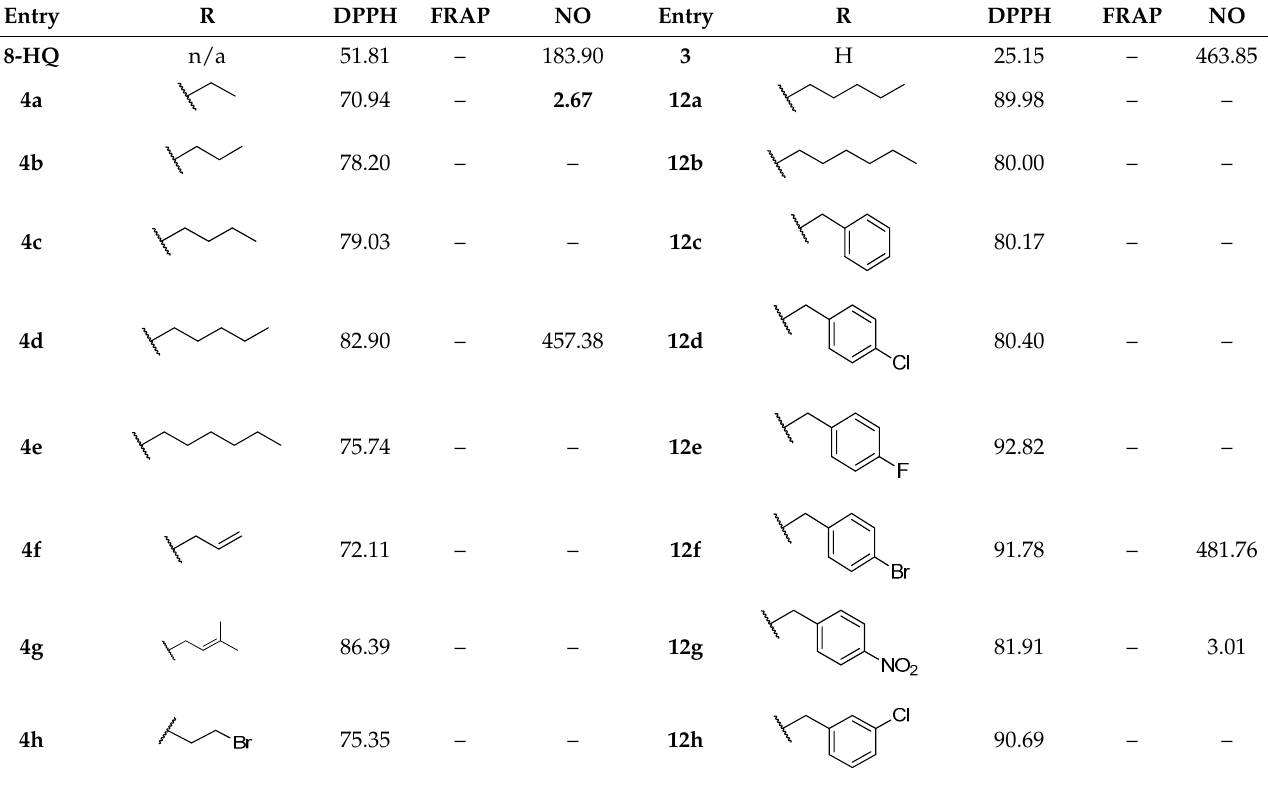
Table 1. IC 50 ( µ M) for antioxidant profiling of compounds 4a – t and 12a – t . Table 1. IC 50 (µM) for antioxidant profiling of compounds 4a – t and 12a – t . Table 1. IC 50 (µM) for antioxidant profiling of compounds 4a – t and 12a – t . Table 1. IC 50 (µM) for antioxidant profiling of compounds 4a – t and 12a – t . Table 1. IC 50 (µM) for antioxidant profiling of compounds 4a – t and 12a – t . Table 1. IC 50 (µM) for antioxidant profiling of compounds 4a – t and 12a – t . Table 1. IC 50 (µM) for antioxidant profiling of compounds 4a – t and 12a – t . Table 1. IC 50 (µM) for antioxidant profiling of compounds 4a – t and 12a – t .